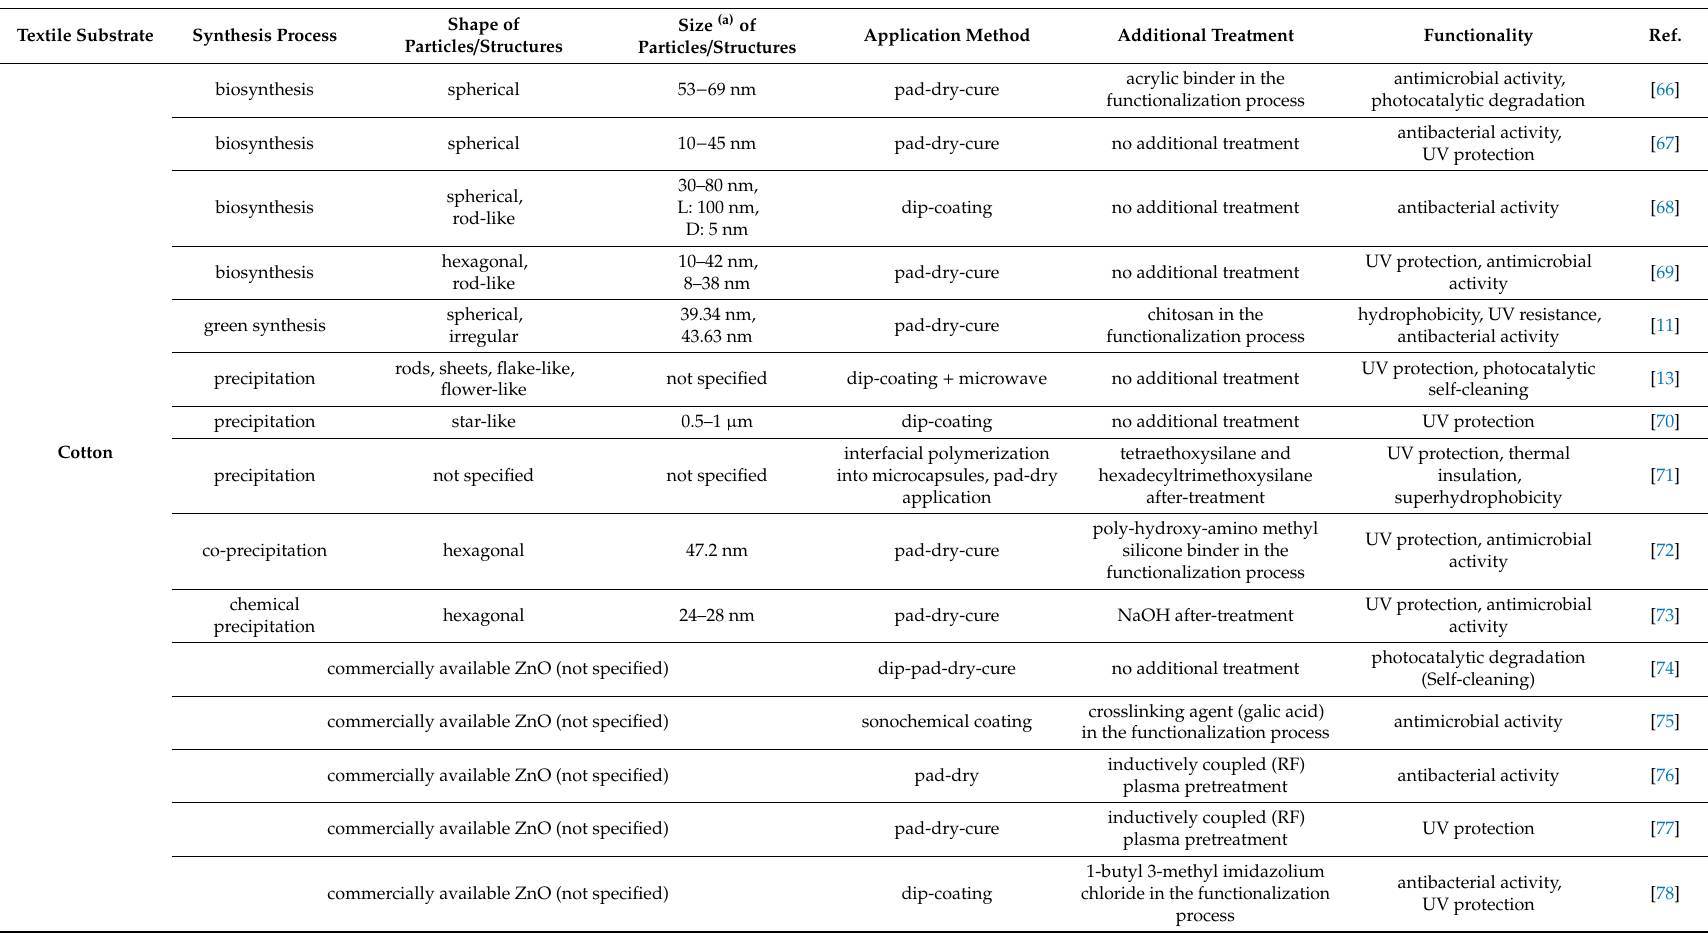
Table 1. Summary of the most recent synthesis procedures and coating methods using ZnO to impart functional properties to textile